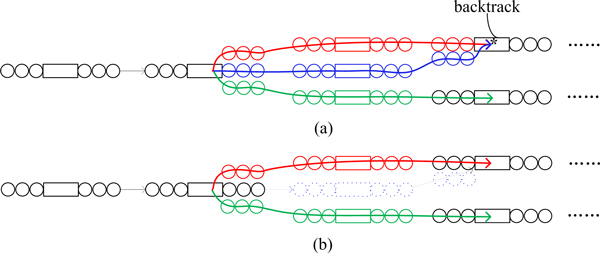
Breadth-first search bubble removal in the sparse k-mer graph. Removing unwanted structures in the sparse de Bruijn graph. (a) Before removal. (b) After removal.